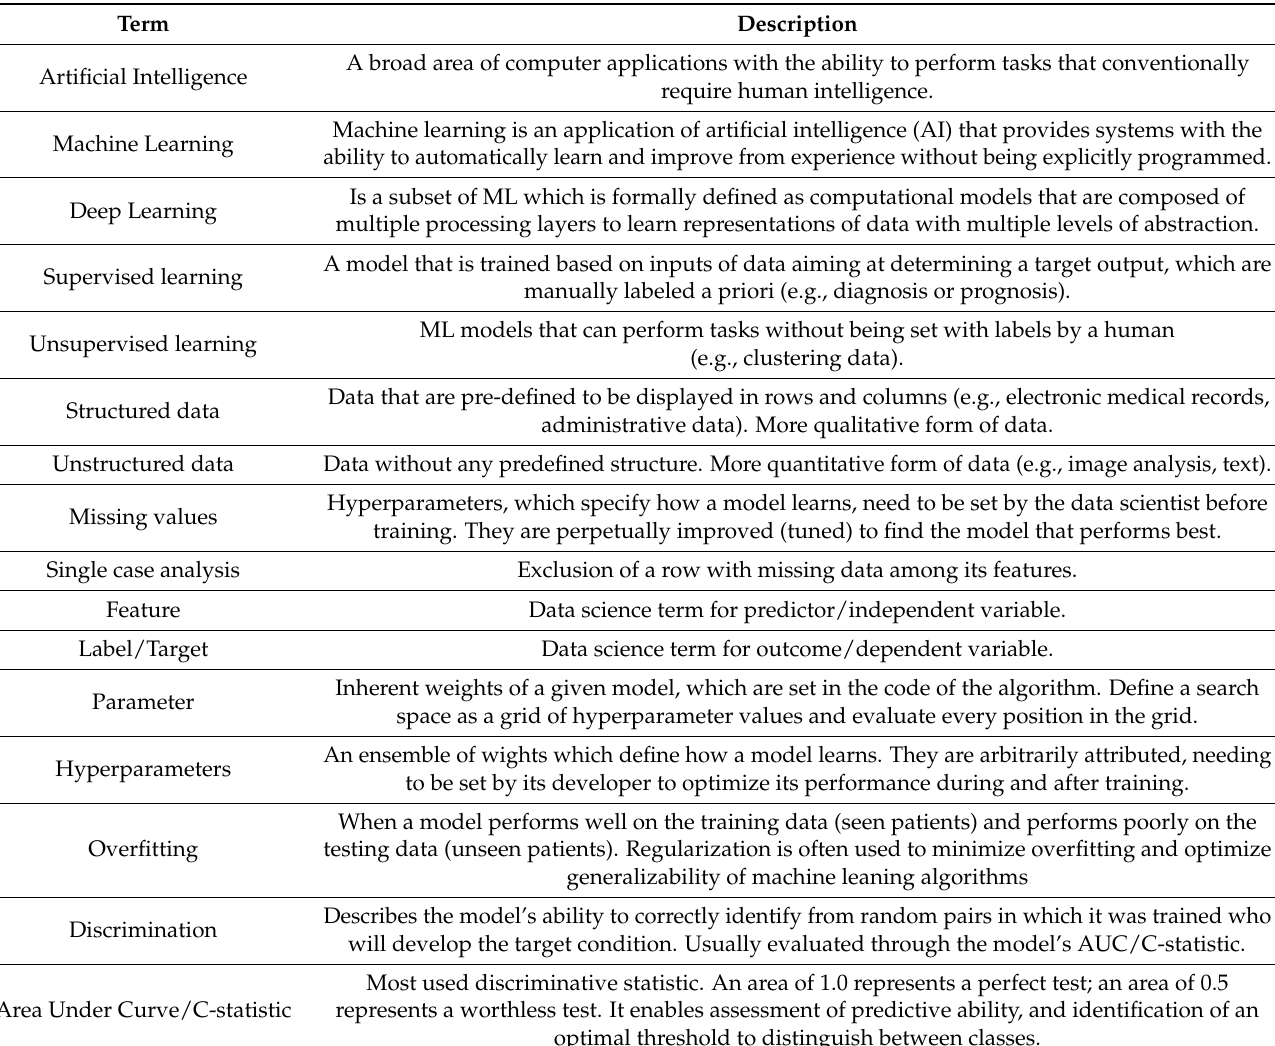
Table 1. Definitions of important concepts in machine learning and artificial intelligence